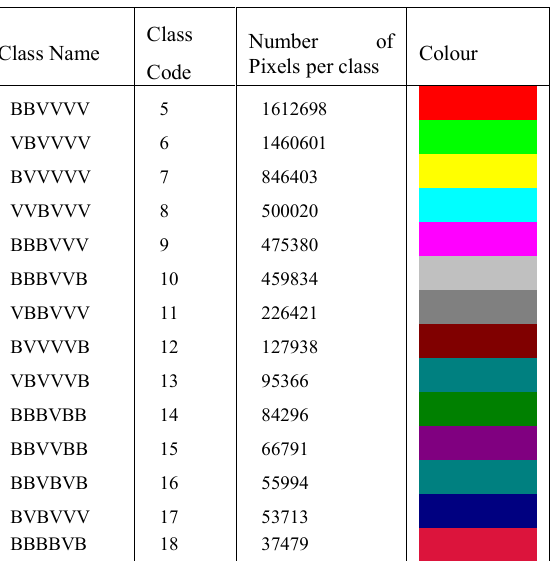
Table 2. Fourteen crop types with highest number of pixels selected for crop type mapping Figure 6 shows crop type map and enlarged window showing details of distribution of different crops. Colours used